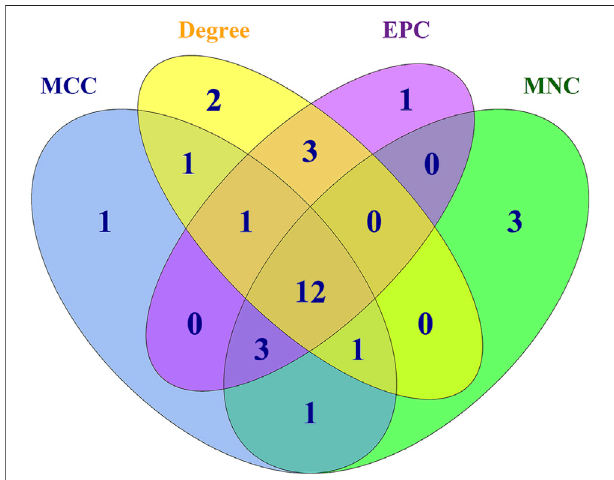
FIGURE 3 | Overlap of genes identi fi ed using the four methods using Cyto-Hubba plugin in PPI. Four methods — Degree, DMNC, MCC, and MNC — were applied to identify signi fi cant hub genes using the four centrality methods.Differentcolorsdenotedivergentalgorithms.Theintersections indicate the common DEGs. The elements common to all four methods were identi fi ed as the 12 core genes: FN1, TPM1, TPM2, UNKL, MYH11, RNF4, CUL1, UBE3B, APP, PDGFA, TLN1, and